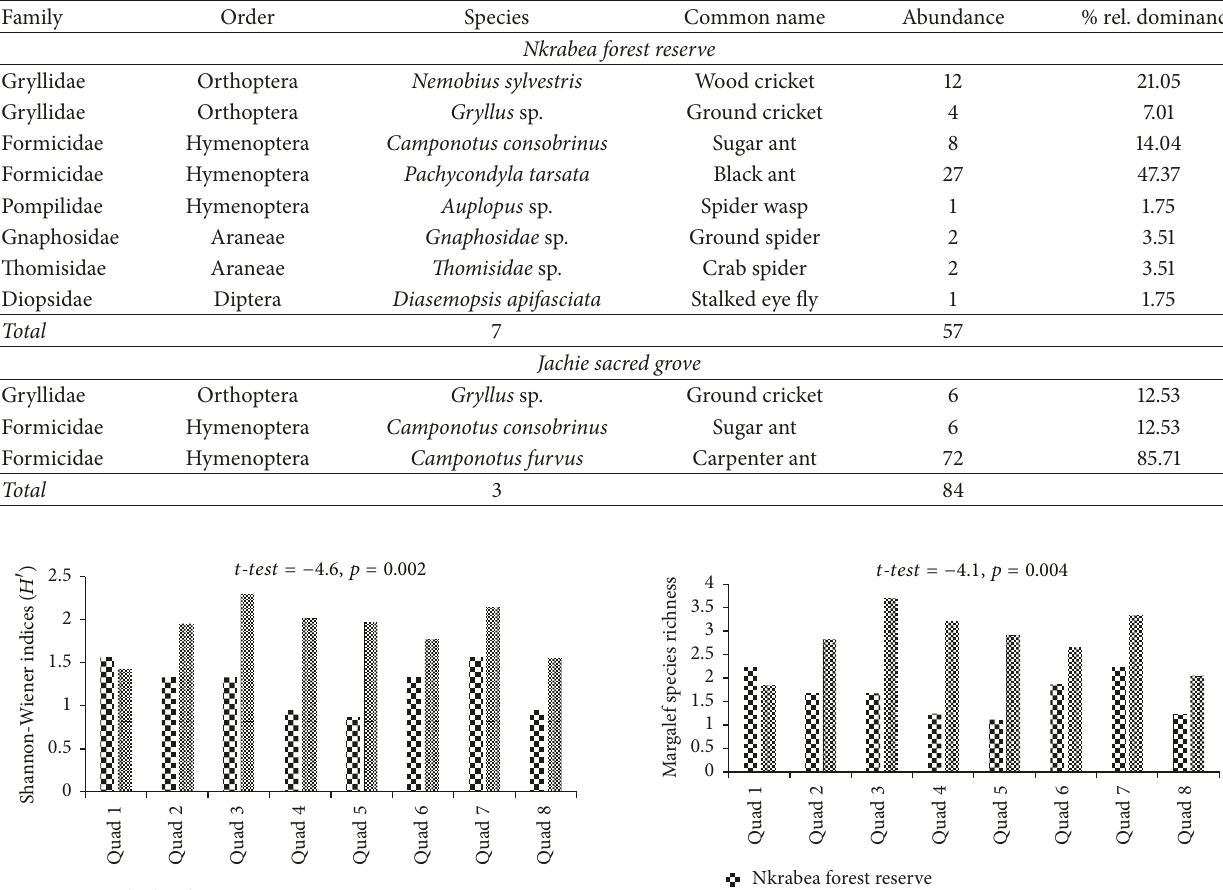
Table 2: Summary of arthropod species and their relative abundance, registered at the study sites.